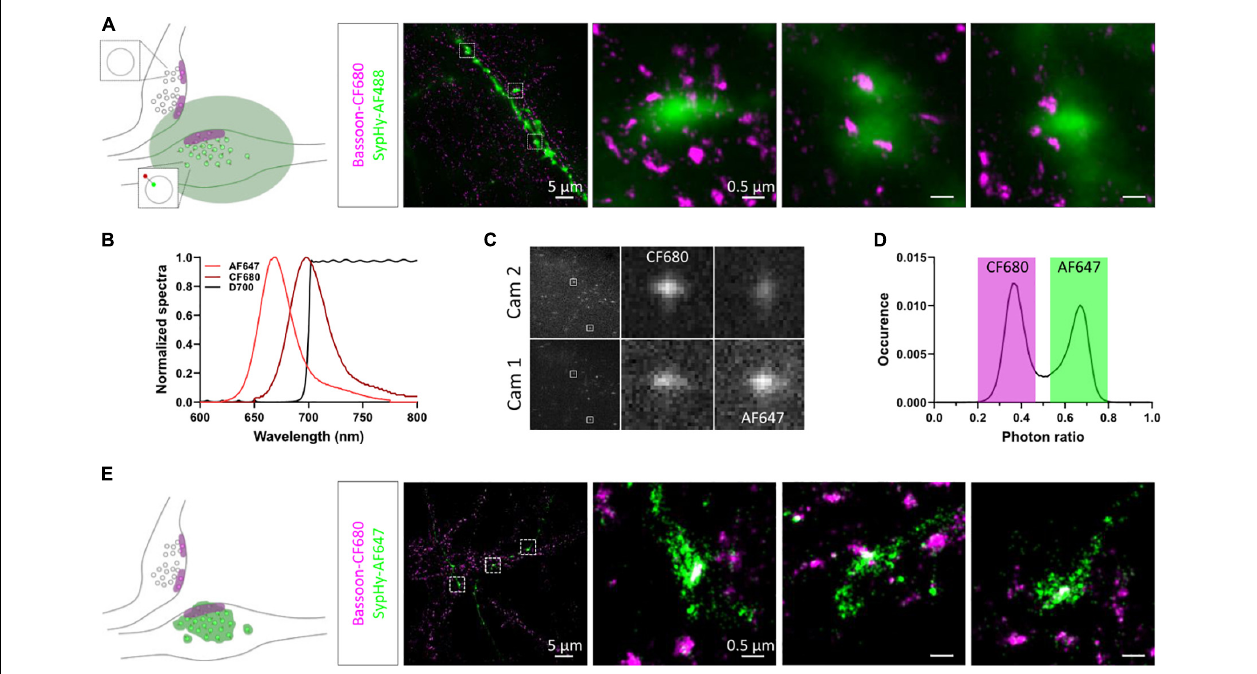
FIGURE 3 | Multicolour 3D-dSTORM to investigate synaptic protein nanoscale organisation. (A) Left panel: schematic of two presynaptic bouton labelled for active zone protein Bassoon resolved with dSTORM. Only one of the two boutons expresses SypHy-RGECO (zoomed synaptic vesicle). The green area represents the diffracted signal from GFP staining imaged with conventional widefield fluorescence microscopy. Right panel: representative example of a widefield image of a SypHy-RGECO + ve axon immunolabelled with AF488 (green) overlaid with a dSTORM image of endogenous Bassoon (magenta) immunolabelled with CF680. Zoomed examples of 3 boutons are shown (square box). (B) Emission spectra of AF647 (light red) and CF680 (dark red), and transmission profile of D700 dichroic (black). (C) Example images of single emitters obtained from the 2 cameras on our SD-dSTORM system and zoomed examples of 2 single emitters. AF647 intensity is stronger on camera 1 than camera 2. CF680 intensity is stronger on camera 2 than camera 1. (D) Distribution of single emitters according to their photon ratio [I cam 1 /(I cam 2 + I cam 1 )] allows separation of AF647 and CF680 detections. (E) Left panel: schematic of two presynaptic bouton labelled for Bassoon resolved with dSTORM. Only one of the two boutons expresses SypHy-RGECO (zoomed synaptic vesicle). The green area represents the super-resolved signal from GFP staining imaged with SD-dSTORM. Right panel: representative example of multicolour 3D-dSTORM of a SypHy-RGECO + axon immunolabelled with AF647 (green) and endogenous Bassoon (magenta) immunolabelled with CF680. Zoomed examples of 3 boutons are shown (square